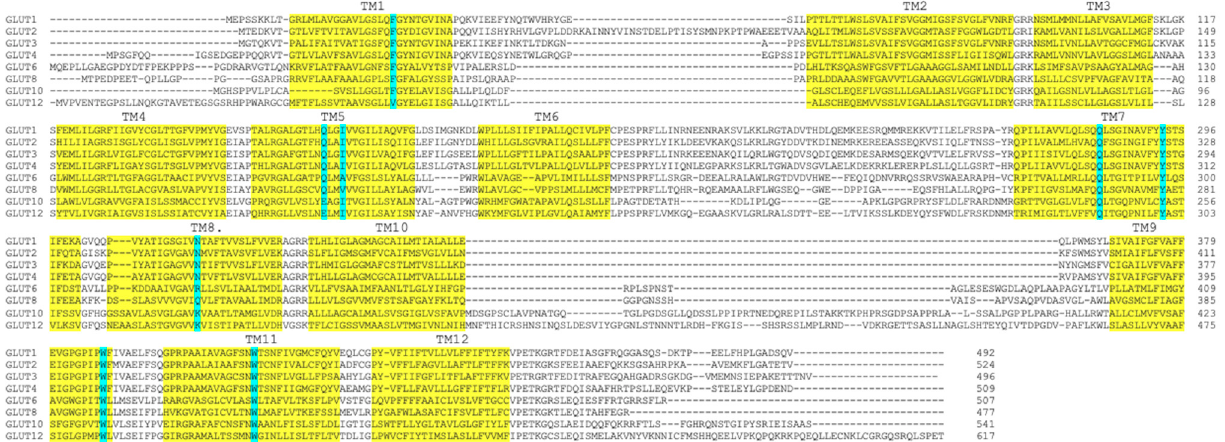
Figure 6. Amino acid sequence alignment of DHA transporters. Transmembrane domains are highlighted in yellow based on the new GLUT1 crystal structure [20,24]. The GLUT1 residues in our study and the equivalent residues among the other members of the GLUT family that transport DHA are marked in blue. Alignment was performed using Clustal 0 (1.2.4).